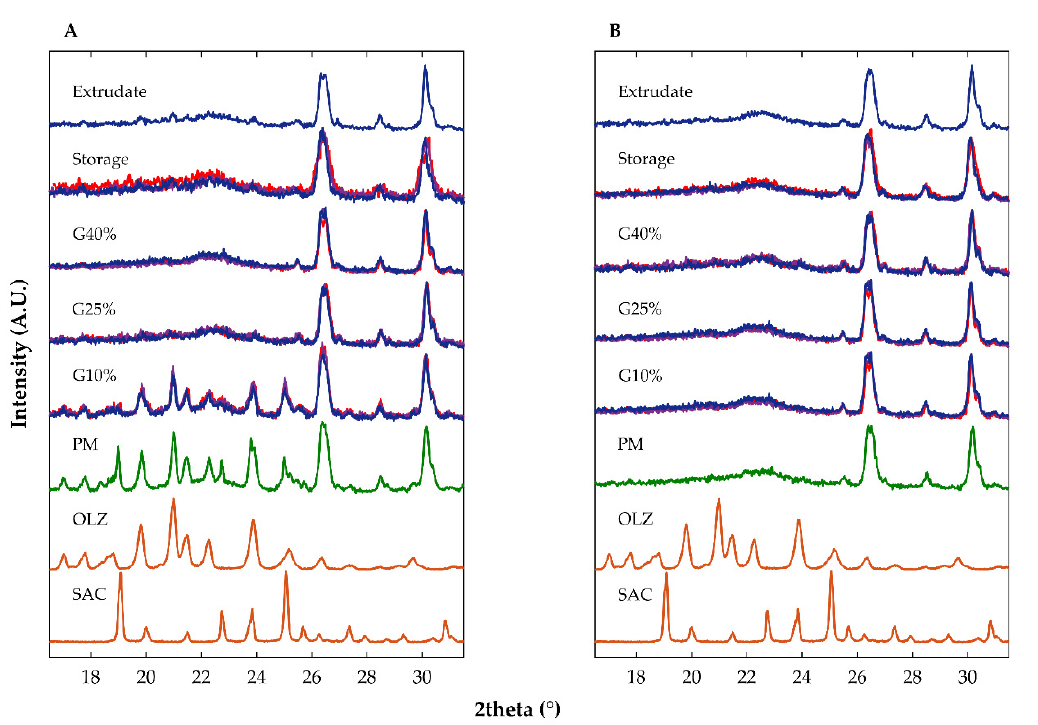
Figure 4. Diffractograms of pure crystalline saccharin (SAC), pure crystalline olanzapine (OLZ) and samples containing olanzapine and saccharin (formulation B) as crystalline forms ( A ) and co- amorphous forms ( B ) after physical mixing (PM), wet granulation (G, using 10, 25 or 40% of water), storage (10% of water) and extrusion. Drying temperature applied to samples: 40 °C (dark blue), 65 °C (purple) and 90 °C (red).